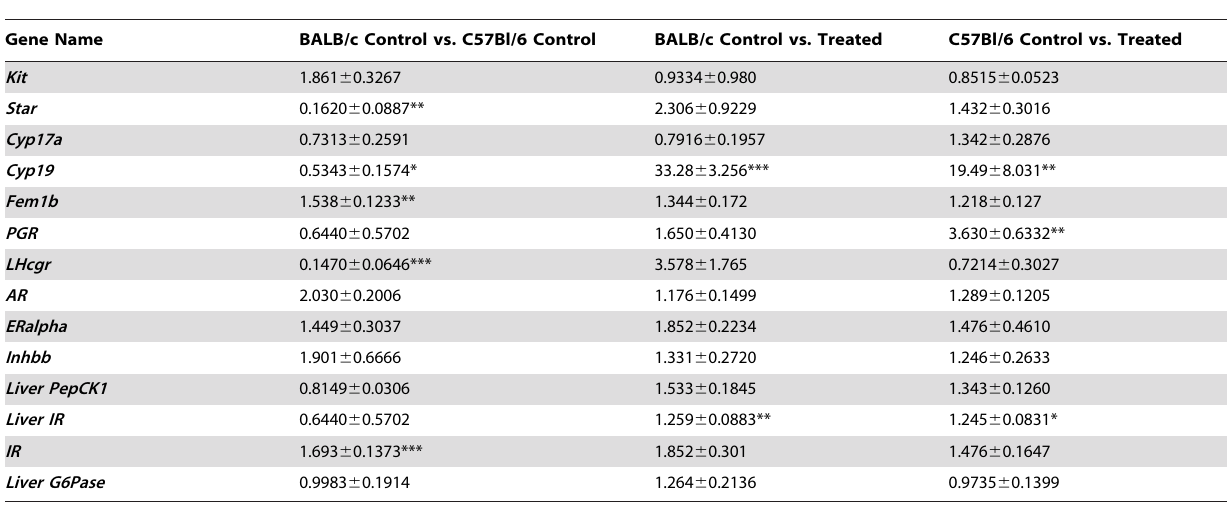
Table 2. Comparison of basal gene expression between strain backgrounds and treatments.